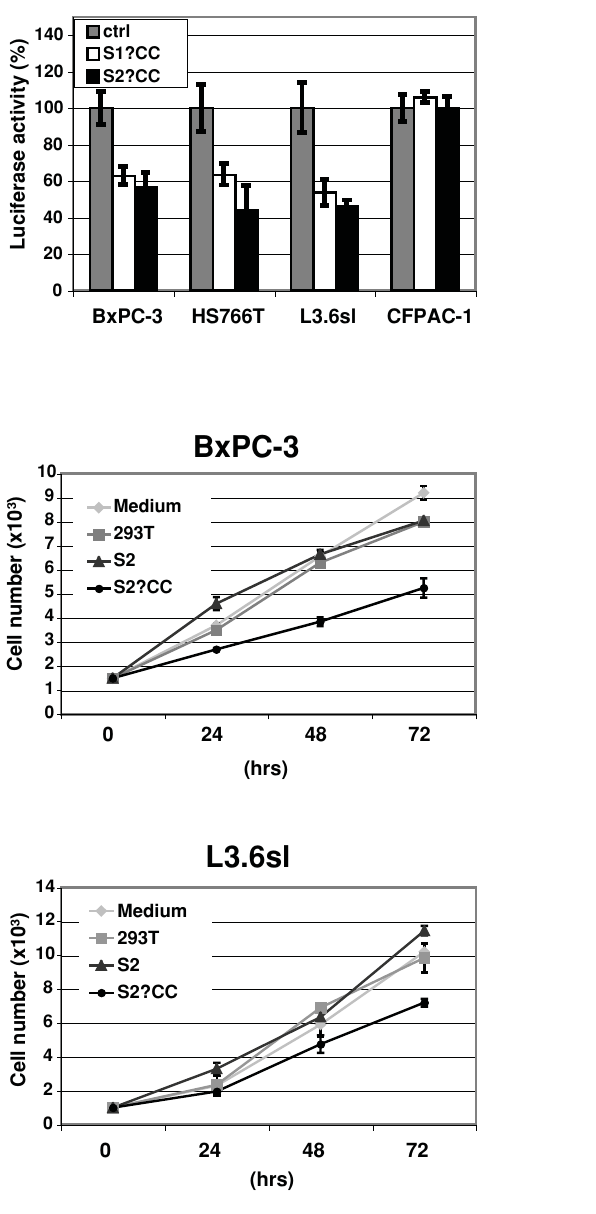
Figure 3. The effects of inactive Sulfs on Wnt signaling on Wnt signaling and cell growth. A : Four pancreatic adenocarcinoma cell lines as indicated were transiently transfected with cDNAs encoding either a catalytically inactive form of Sulf-1 (‘‘S1 D CC’’) or a catalytically inactive form of Sulf-2 (‘‘S2 D CC’’) or with the empty vector (‘‘control’’). The mutants were made by replacing two adjacent cysteines with alanines. Wnt signaling was determined by utilizing the TOP/FOPflash reporter system. The values shown are the means 6 SD’s for 4 independent determinations and differences between mutant and control cells were statistically significant with p values , 0.02 for BxPC-3, HS766T and L3.6sl cells (Student t-test). B: The pancreatic adenocarcinoma cell lines were cultured with conditioned medium derived from each of the following: parental HEK-293 cells (‘‘control’’), HEK 293T cells stably expressing wild-type Sulf-2 (denoted ‘‘Sulf-2’’), or expressing a catalytically inactive form of Sulf-2 (‘‘S2 D CC’’). Wild-type Sulf-2 protein and the mutant were present in the conditioned medium of the two producing cells at approximately equivalent levels. Wnt signaling was determined as before with the TCF-luciferase reporter assay. The values shown are the means 6 SD’s for 3 independent determinations and differences between Sulf-2 mutant and control were statistically significant for BxPC-3 (p=0.002), HS766T (p=0.01) and L3.6sl (p=9 6 10 2 6 ) (Student t-test). C: The pancreatic adenocarcinoma cell lines were cultured in a transwell system over feeder layers consisting of: medium alone (‘‘Medium’’); parental HEK 293T cells (‘‘HEK 293T’’); HEK 293T cells stably producing wild-type Sulf-2 (‘‘Sulf-2’’); or a catalytically inactive form of Sulf-2 (‘‘S2 D CC’’). Cell growth was monitored by hemacytometer counting for 4 days. The values shown are the means 6 SD’s for 3 independent determinations.